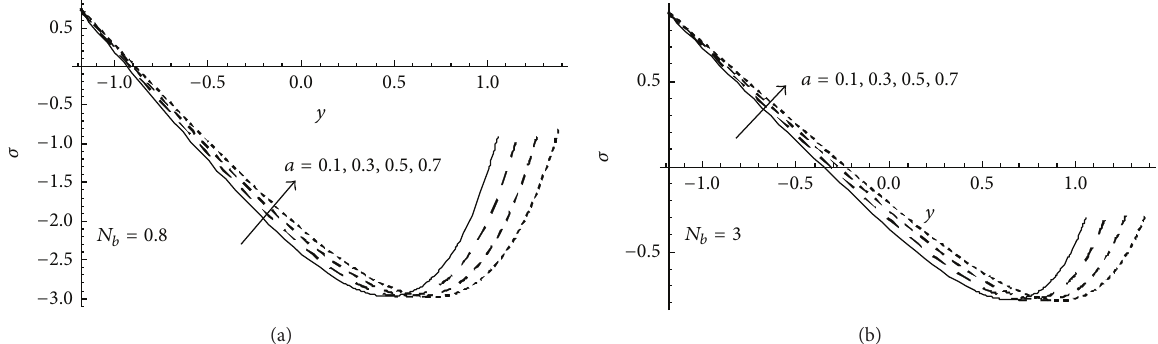
Figure 6: Variation of nanoparticle concentration at different values of 𝑎 when 𝑁 𝑡 = 5 , 𝑑 = 1 , 𝑏 = 0.5 , 𝑥 = 1 , 𝜙 = 0.2 , 𝛾 = 0.1 , and 𝛾 1 = 0.1 for (a) 𝑁 𝑏 = 0.8 and (b) 𝑁 𝑏 = 3